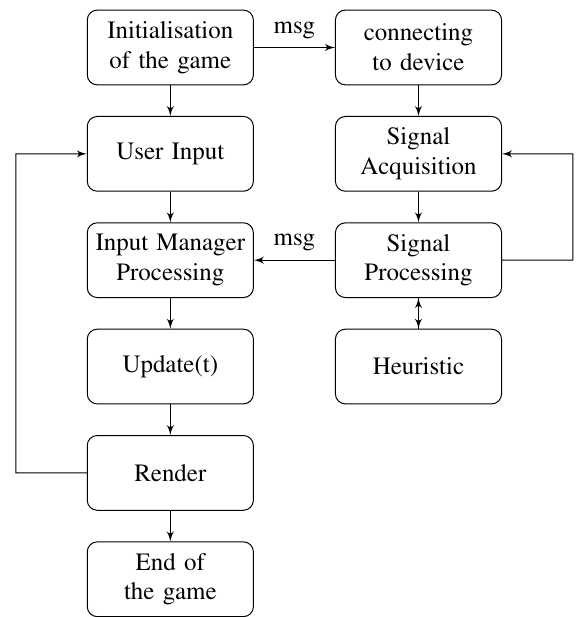
Figure 1: Workflow of the game